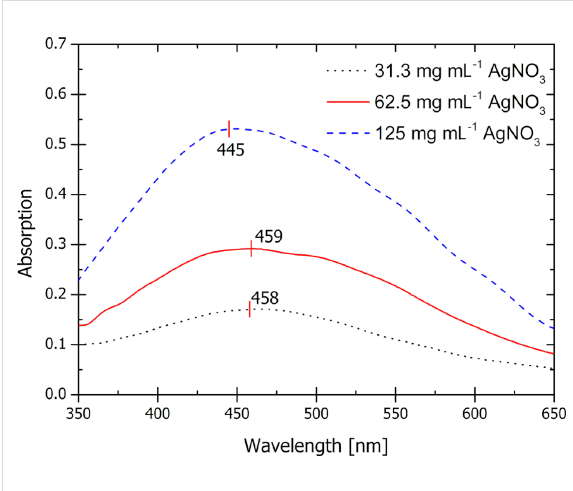
Figure 2: UV–vis absorption spectra of silver nanocomposites at silica wafers after post-exposure bake at 95 °C with varying AgNO 3 precursor concentrations. The absorption increases with increasing amounts of AgNO 3 precursor added.